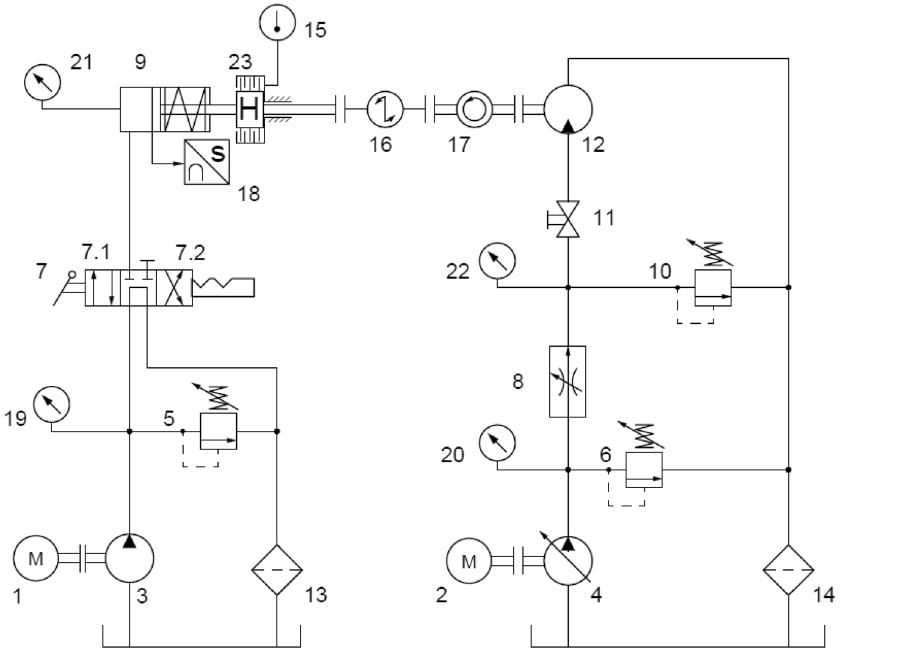
Figure 7. Hydraulic circuit 13,20 : 1, 2—electric motor, 3, 4—pumps, 5, 10—relief valves, 6—pressure valves, 7—4/3 directional valve, 8—flow control valve, 9—hydraulic actuator, 11—ball valve (shut-off valve), 12— hydraulic motor, 13, 14—filters, 15—temperature transducer, 16—torque transducer, 17—angular velocity sensor, 18—displacement sensor, 19–22—pressure transducers, 23—clutch.